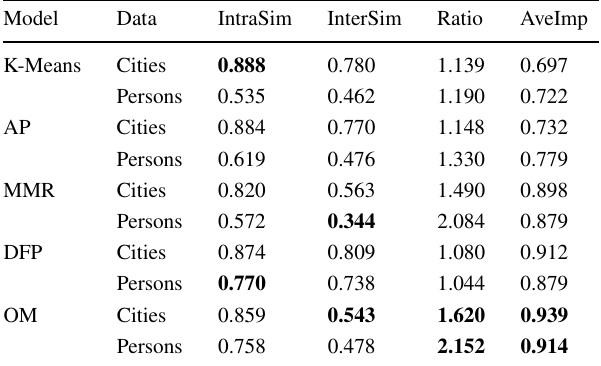
Table 4 Performance of different models on the city and person data-